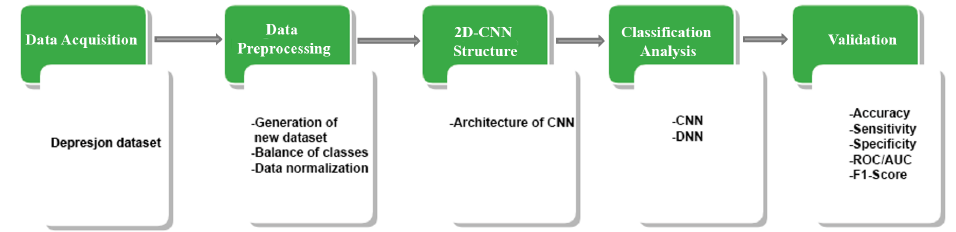
Figure 1. Flowchart of the methodology proposed. The green squares refer to data processing methodology while the white squares detail the task involved in each